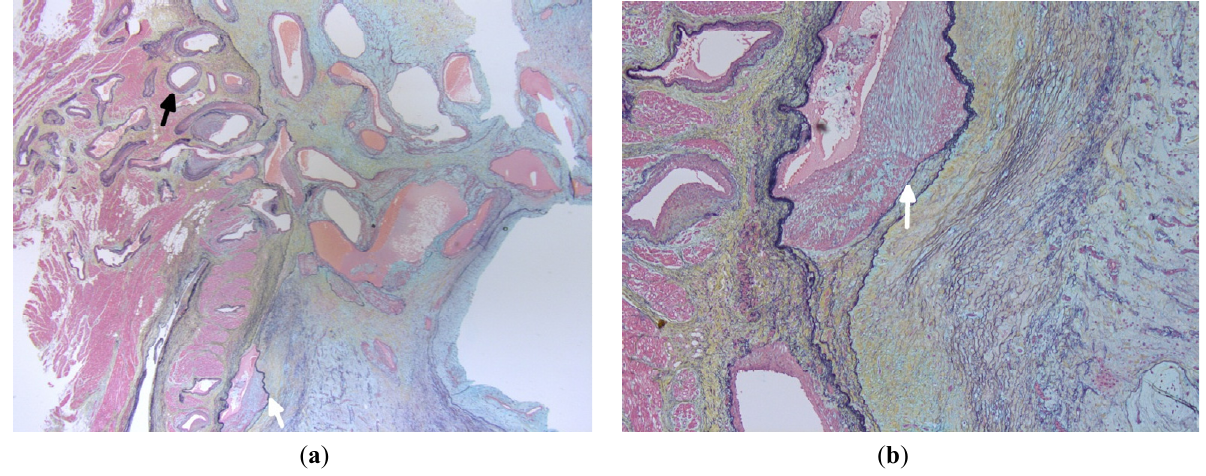
Figure 6. ( a , b ) Sections from the base of cardiac myxoma shows increased vascularity with thick walled blood vessels (black arrow) some of which show intimal hyperplasia (white arrow). (Stain ( a , b ): Movat pentachrome; Original magnification: ( a ) ×2.5; ( b )